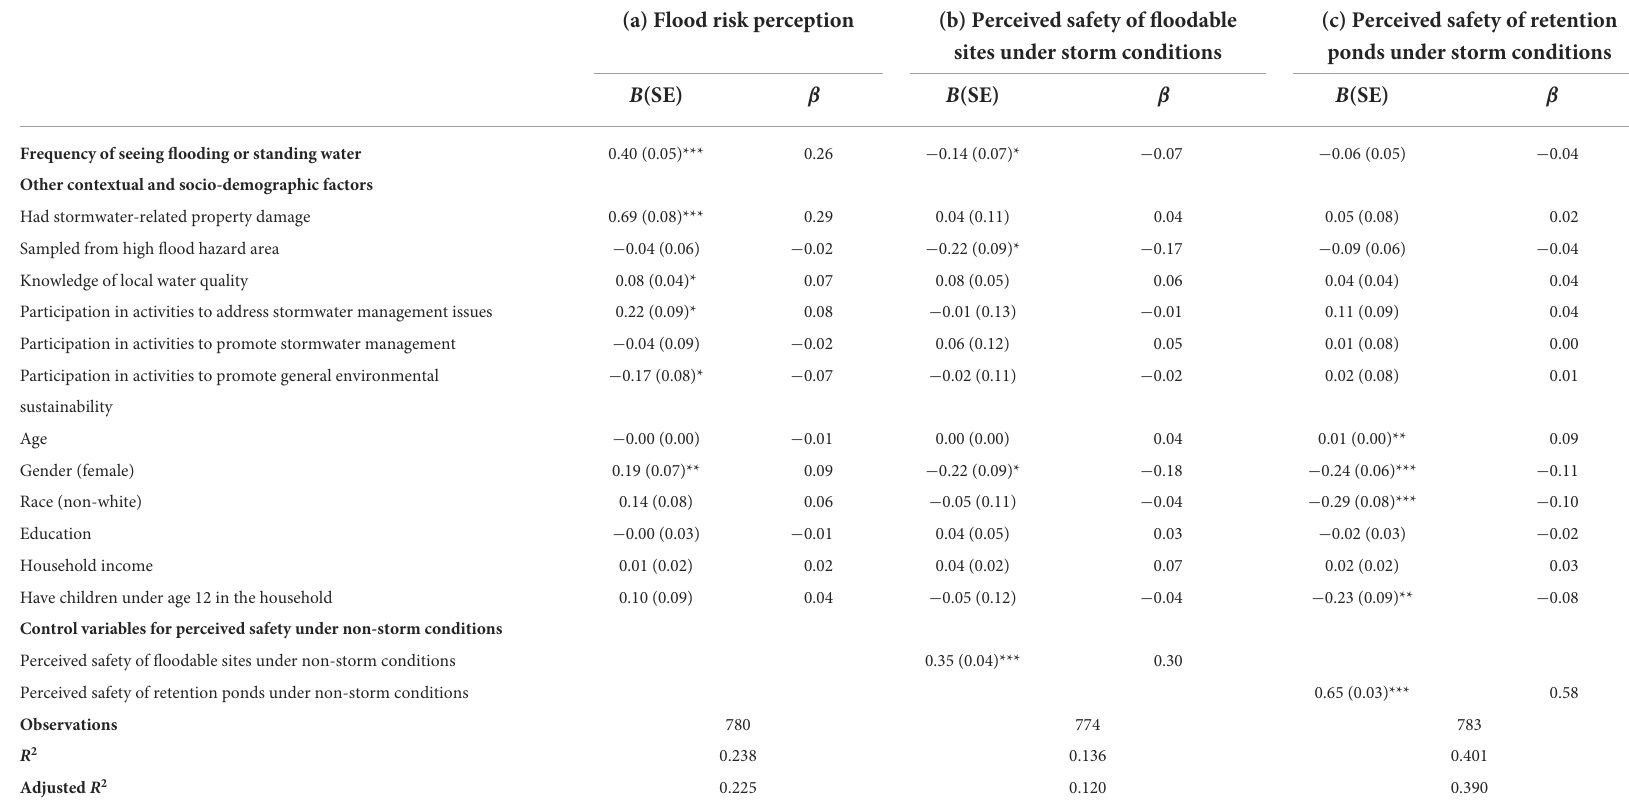
TABLE 6 Results from multiple linear regression models for (a) flood risk perception, (b) perceived safety of floodable sites under storm conditions, controlling for perceived safety under non-storm conditions, and (c) perceived safety of retention ponds under storm conditions, controlling for perceived safety under non-storm conditions. (a) Flood risk perception (b) Perceived safety of floodable (c) Perceived safety of